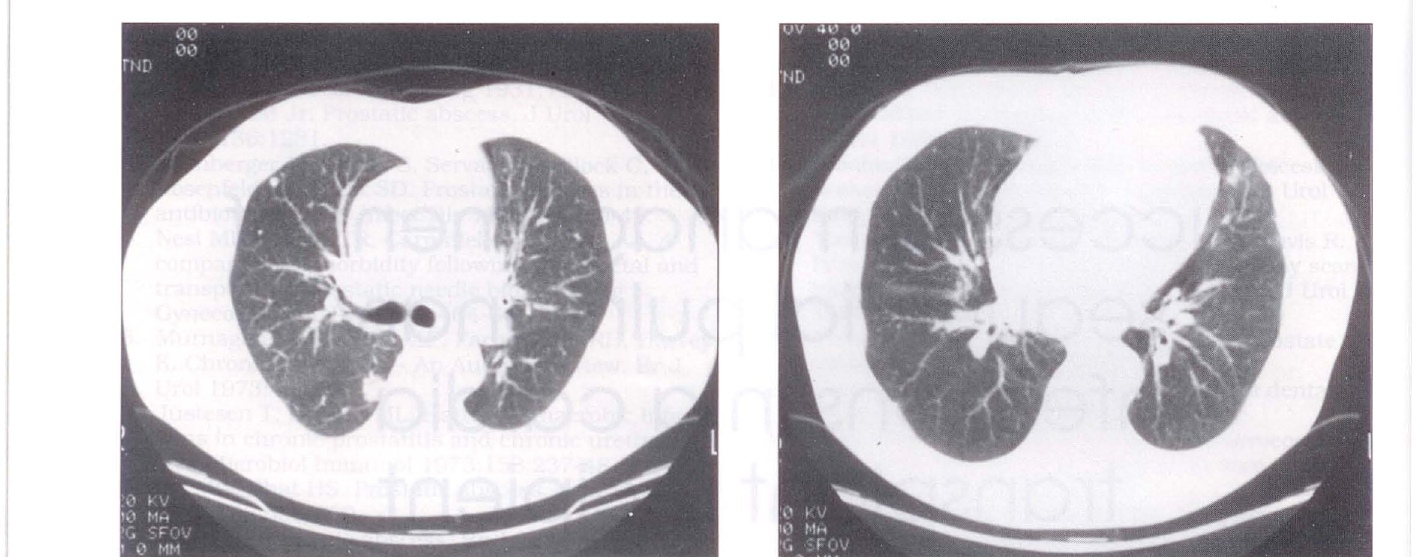
Figure 1) Representative sections of computed tomography scans of the chest done on admission demonstrate multiple pulmonary nodules in the right upper lobe (left) and a portion of a nodule within the lingula. adjacent to the cardiac apex (right). Biopsy of one of the nodules revealed Aspergillus